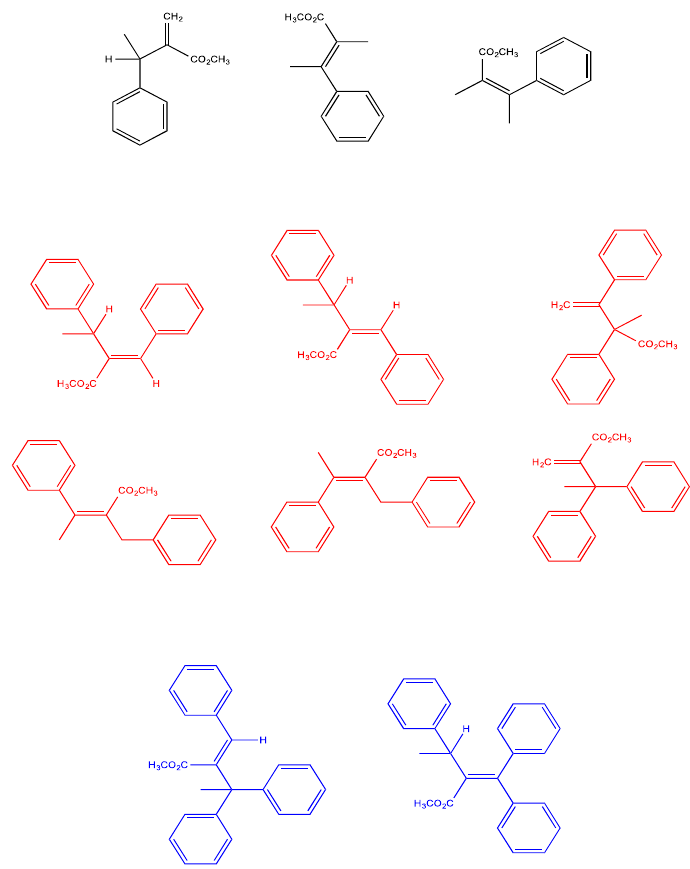
Figure 16. Postulated structures of multiple phenylboronic acid additions to the products of the bis(amino acid)Pd(II) catalyzed coupling of phenylboronic acid and methyl tiglate. First addition = black, second addition = red, third addition = blue.